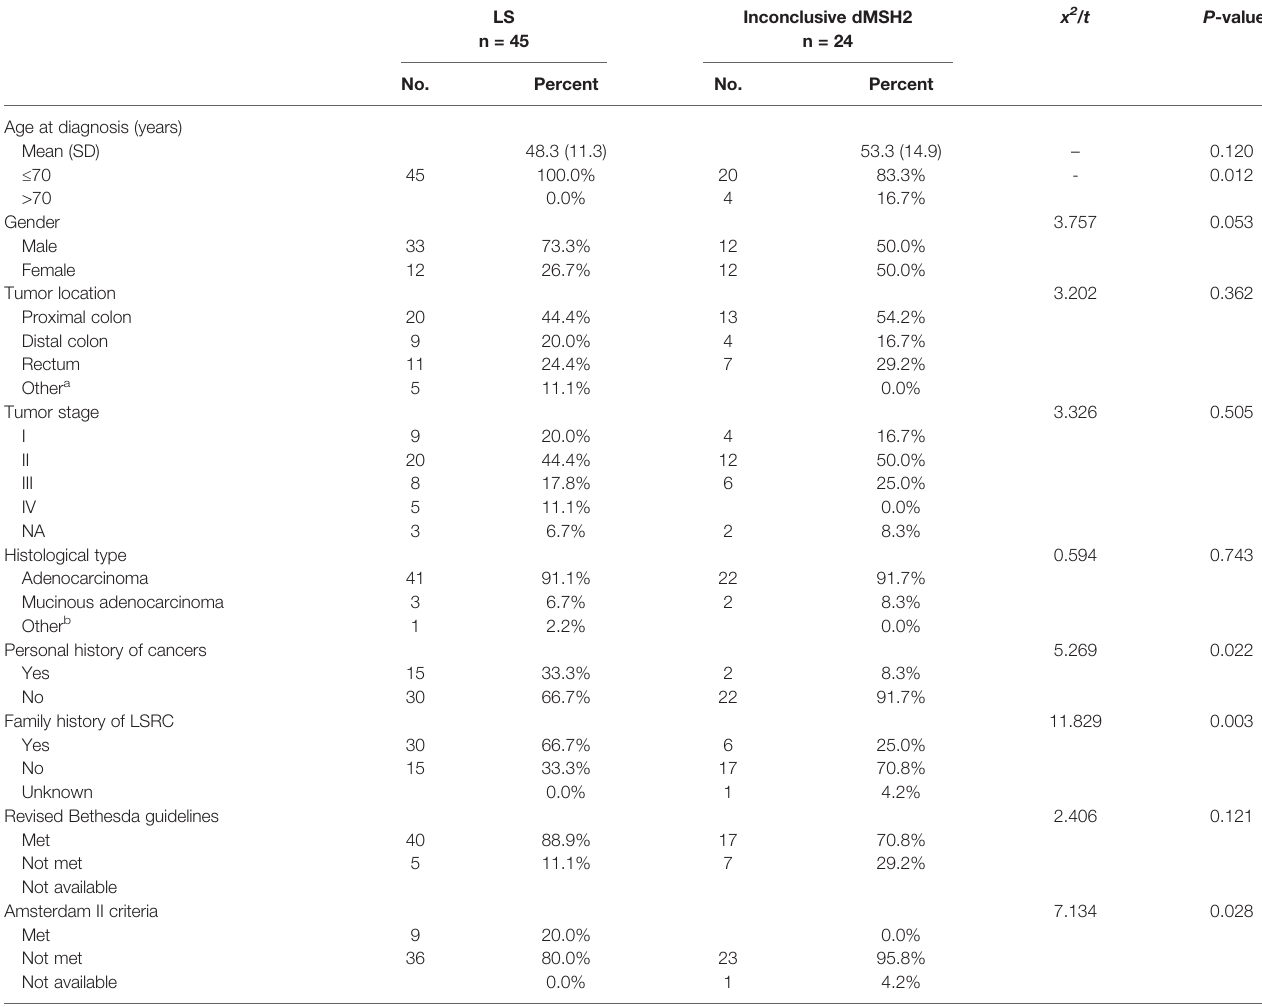
TABLE 1 | Clinicopathological characteristics of patients with MSH2-de fi cient